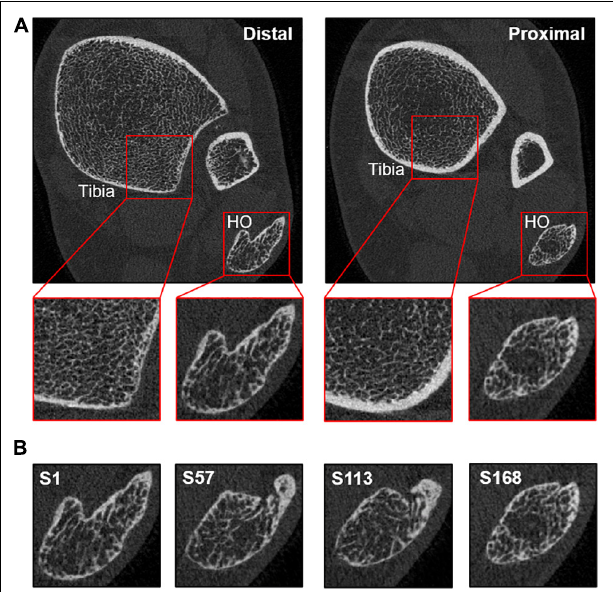
FIGURE 2 | (A) Distal (left) and proximal (right) slice of the HR-pQCT scan of the left tibia of patient 1, a 33-year-old female fibrodysplasia ossificans progressiva (FOP) patient showing isolated heterotopic ossification (HO) in the Achilles tendon. Quantification showed dissimilarities between the HO and the patient’s tibia, especially in trabecular microarchitecture when compared to an age- and gender-matched reference. (B) Four slices from distal (left) to proximal (right) of the HR-pQCT scan of the left tibia showing HO in the Achilles tendon.